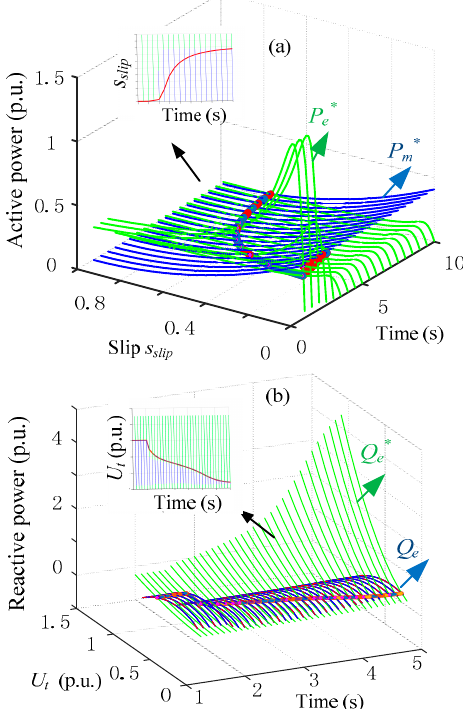
Figure 10. Three-dimensional diagram of an abnormally low voltage after a disturbance: ( a ) air-gap power and mechanical power versus slip curves; and ( b ) reactive power demand and supply versus terminal voltage magnitude curves.